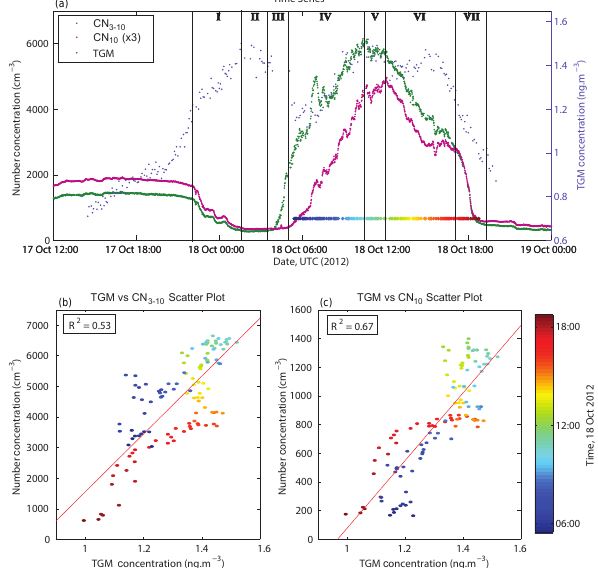
Figure 8. TGM and number concentrations of aerosols in the two measured size bins during the particle formation event. (a) Time series showing variations in concentrations of aerosols and TGM. (b) and (c) show correlation plots relating TGM with CN 3 − 10 and CN 10 , respectively. Both correlation plots show positive re- lationships, with deviations occurring primarily because of short- term variations in aerosol concentrations. The correlation plots are coloured according to time of day (referenced directly in a ) and in- clude robust linear regression lines with corresponding R 2 values. Removal of the “wings” of plot (b) , a result of varying background concentrations (see text), increases the R 2 value to